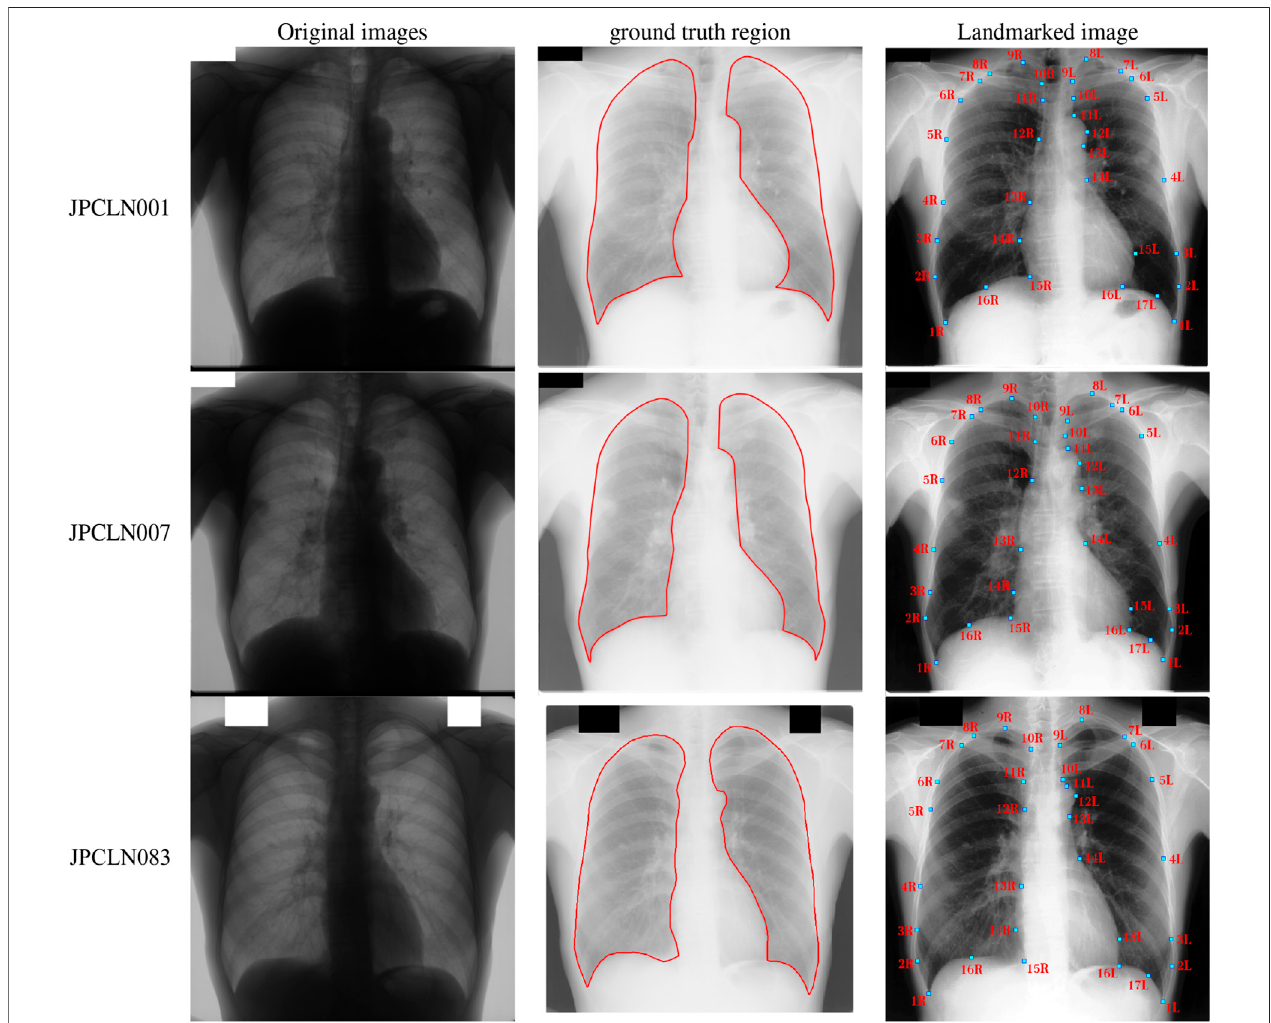
FIGURE1| SelectedimagesfromJSRTdataset,groundtruthoftheleftandrightlung fi eldregions,andtheplacementofmanuallyannotatedanatomicallandmark points after negative transformation.